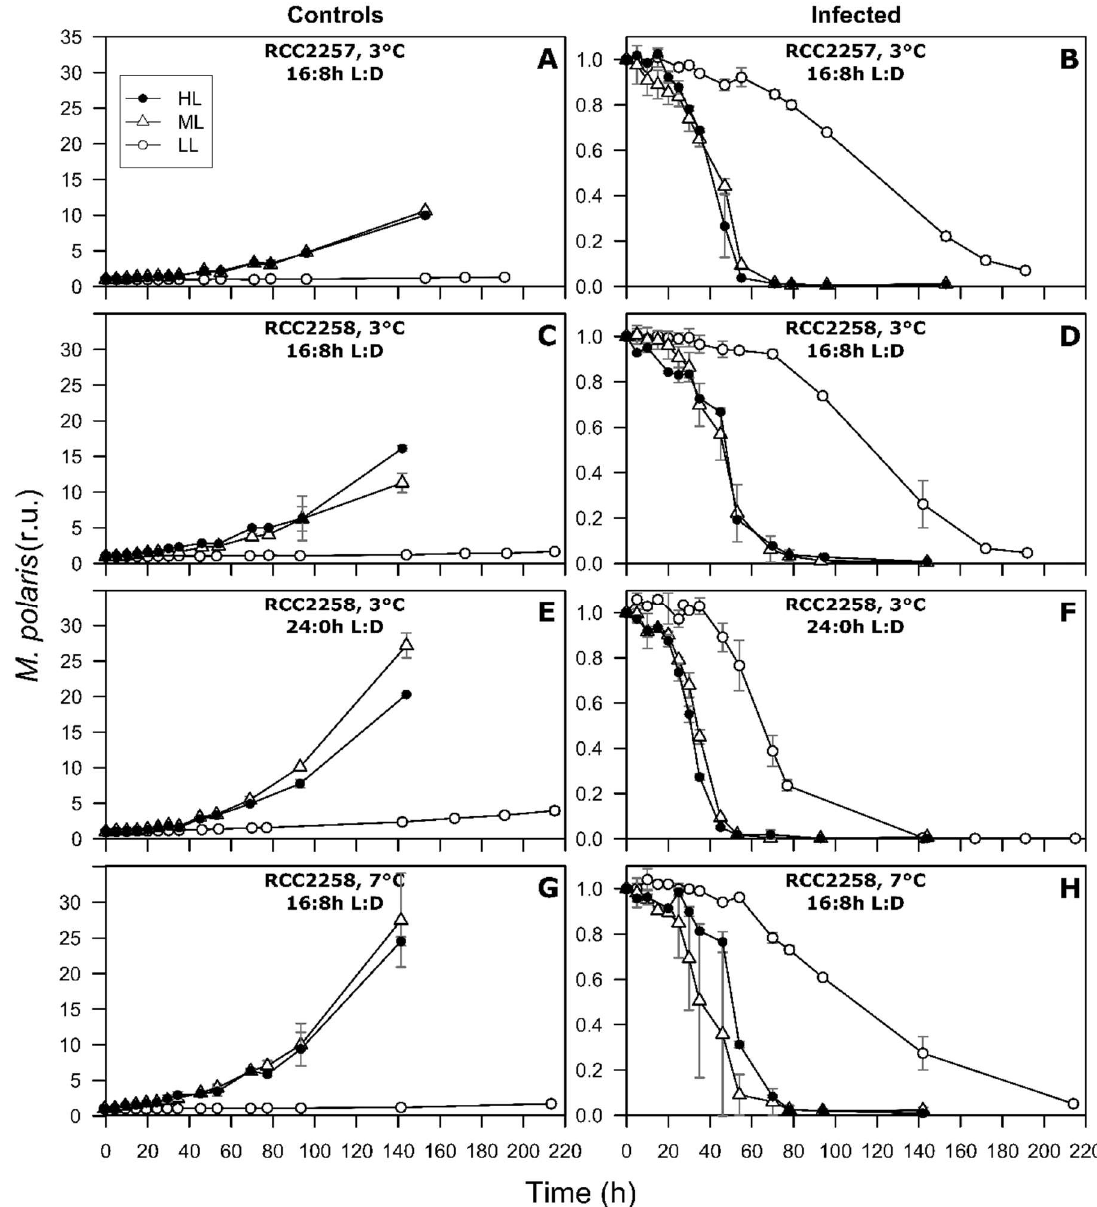
Figure 1. Temporal dynamics of algal abundances (in r.u., normalized to the initial abundance) for non-infected controls and MpoV-45T infected Micromonas polaris RCC2257 ( A , B ) and RCC2258 ( C – H ), cultured at 3 ◦ C ( A – F ) and 7 ◦ C ( G , H ), with a 16:8 h ( A – D , G , H ) and 24:0 h ( E , F ) light:dark (L:D) cycle and different light intensities (LL, ML and HL, i.e., respectively, 5, 60 and 160 µ mol quanta m − 2 s − 1 ). LL at 3 ◦ C and 16:8 h L:D cycle and ML at 7 ◦ C and 16:8 h L:D have n = 4, ML at 3 ◦ C and 16:8 h L:D has n = 6, all the other conditions have n = 2. Error bars represent standard deviation and r.u. stands for relative units.